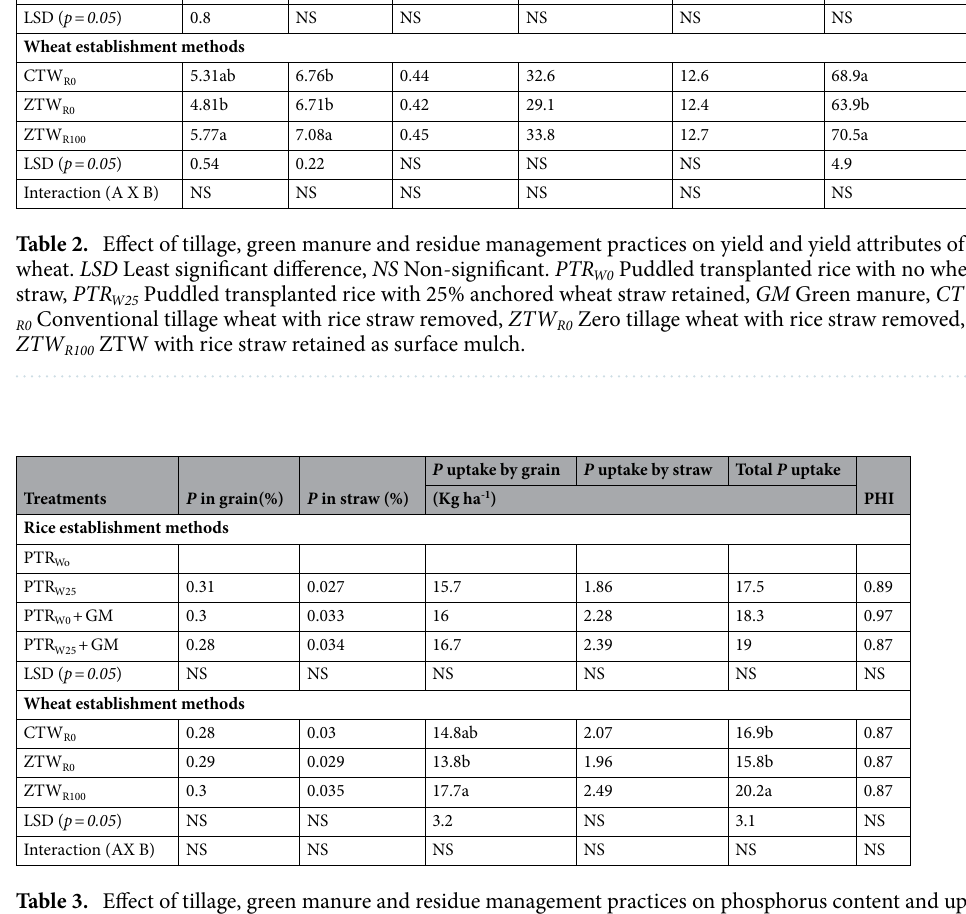
Table 3. Effect of tillage, green manure and residue management practices on phosphorus content and uptake in wheat after five years of rice–wheat cropping system. LSD Least significant difference, NS Non-significant, PTR W0 Puddled transplanted rice with no wheat straw, PTR W25 Puddled transplanted rice with 25% anchored wheat straw retained, GM Green manure, CTW R0 Conventional tillage wheat with rice straw removed, ZTW R0 Zero tillage wheat with rice straw removed, ZTW R100 ZTW with rice straw retained as surface